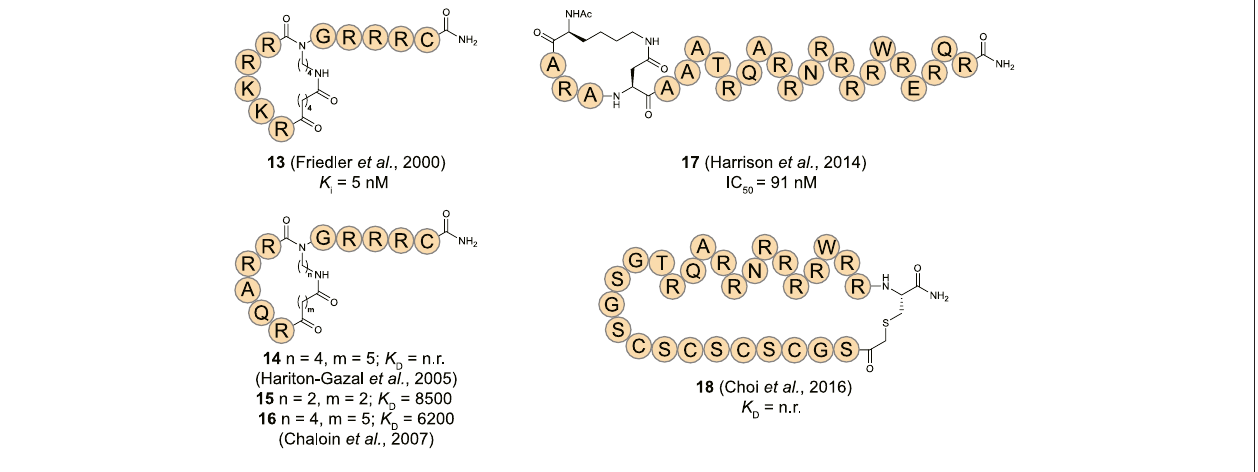
FIGURE 7 | Structures of HIV RRE RNA binding cyclic peptides. n. r. = not